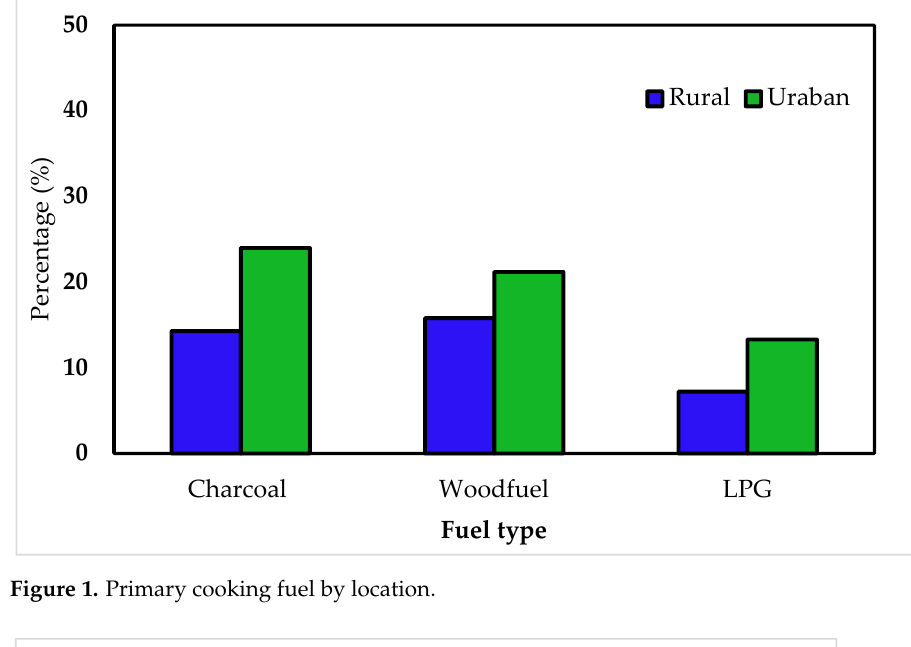
Figure 1. Primary cooking fuel by location. Int. J. Environ. Res. Public Health 2021 , 18 , x